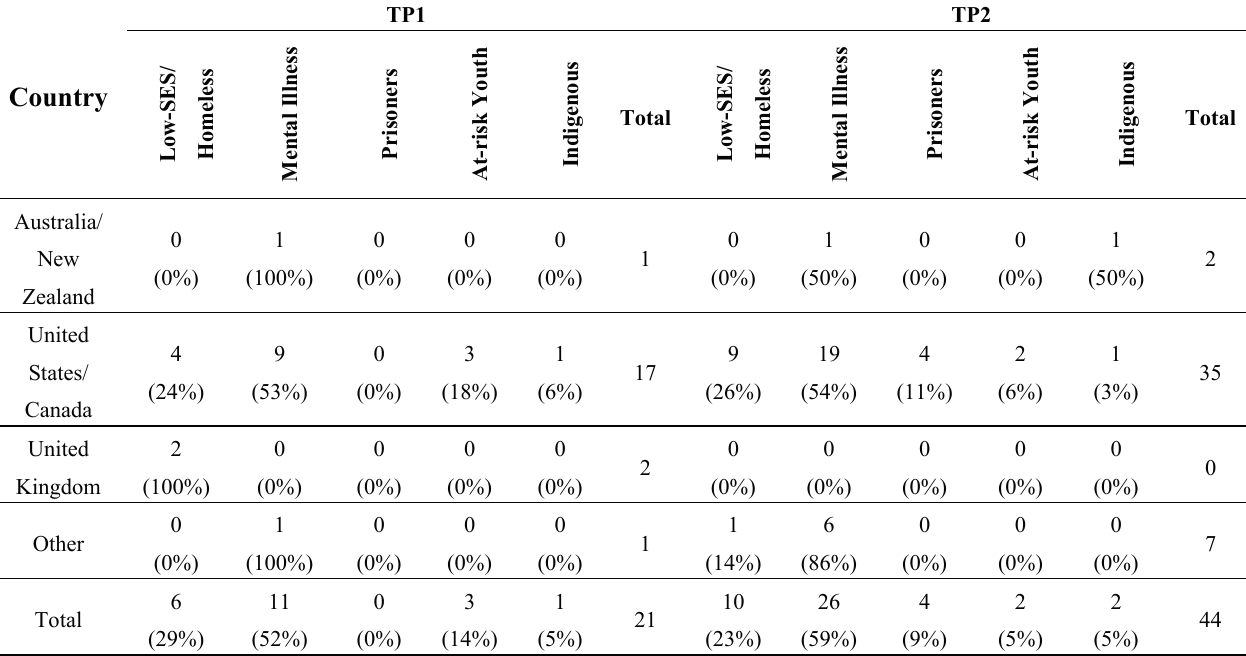
Table 4. Number of intervention studies using EPOC accepted evaluation design by country and population group represented by number of publications and proportion (%)